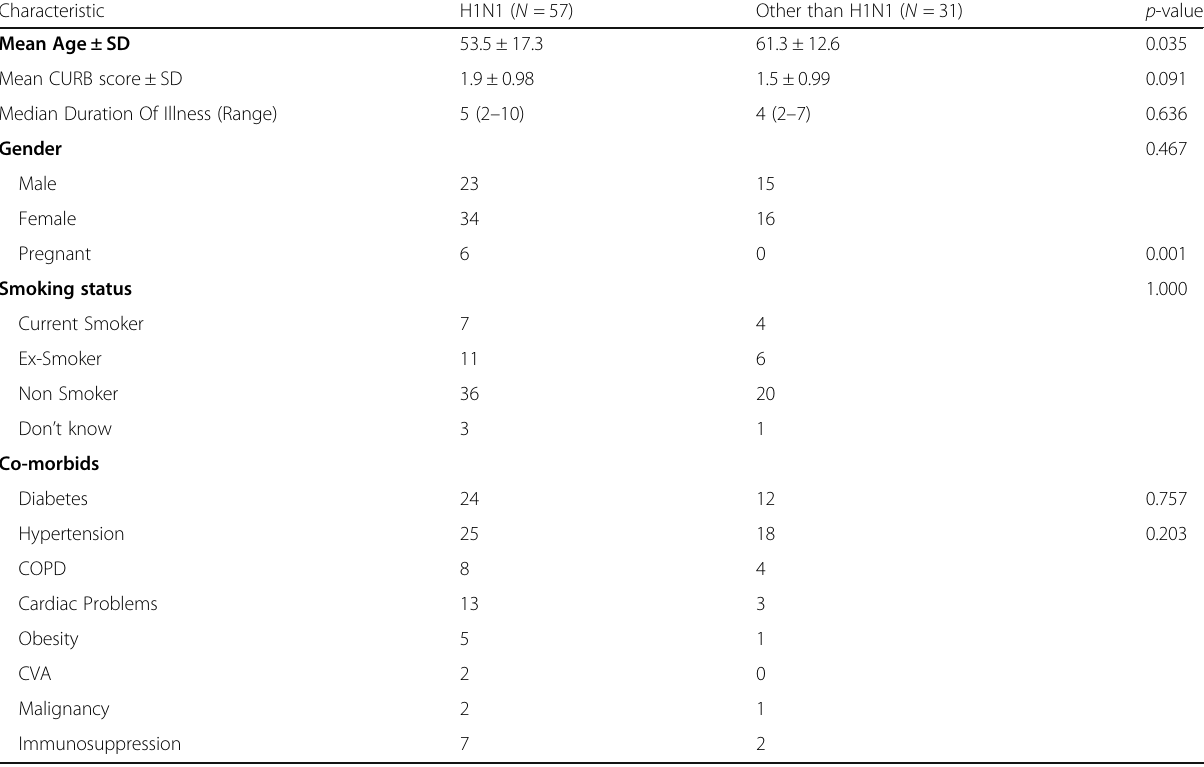
Abbreviations: COPD Chronic Obstructive Pulmonary disease; CVA Cerebrovascular